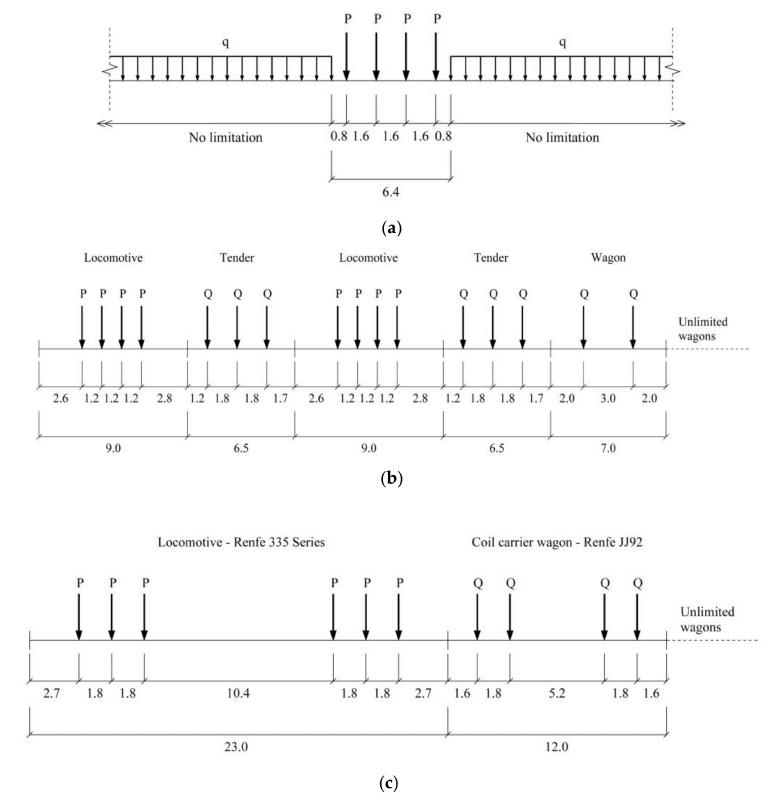
Figure 4. Train load models considered for the global FE analysis of the bridge (all dimensions in m). ( a ) UIC Load Model 71 according to [25]. ( b ) Load Model of the Spanish Standard for Railway Bridges in 1902 according to [29]. ( c ) Renfe 335 Series Locomotive + Renfe JJ92